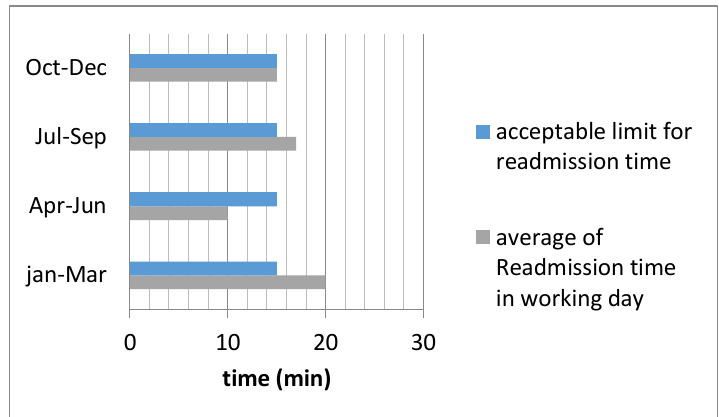
Fig. 8. The Re-admission time in general surgery department.